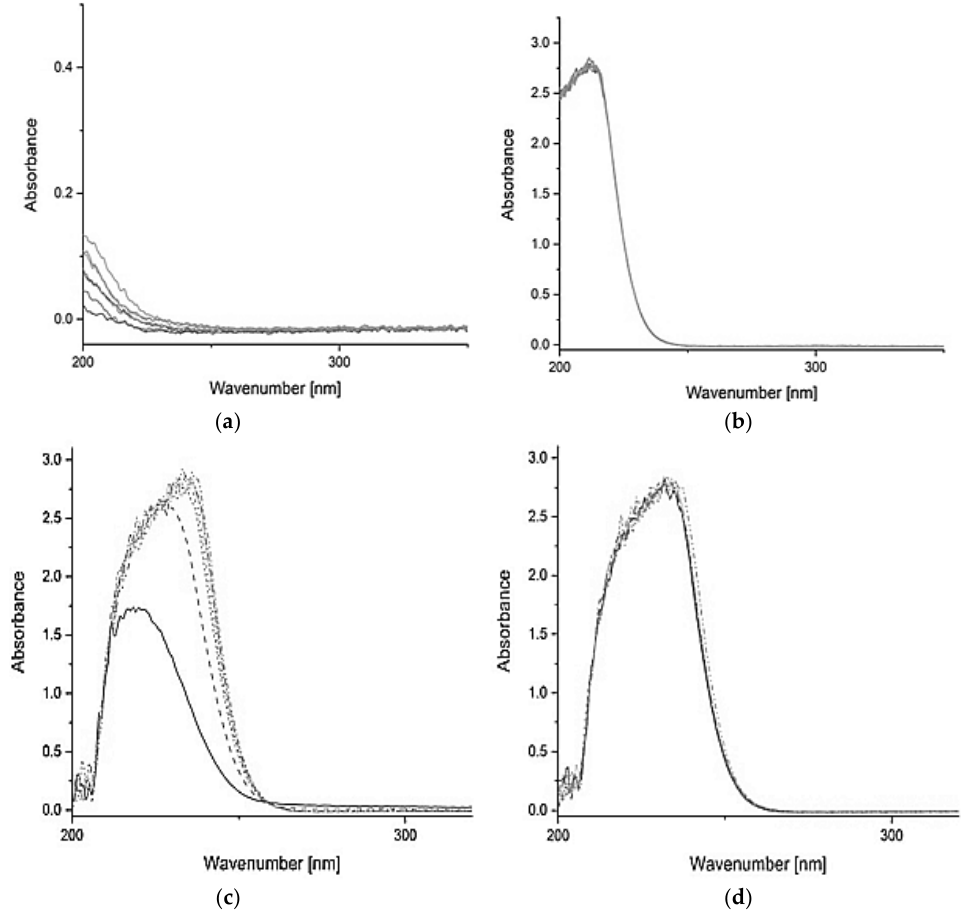
Figure 4. UV-VIS spectra of deionized WST ( a ), deionized WTS ( c ), tap WST ( b ), and tap WTS ( d ). In